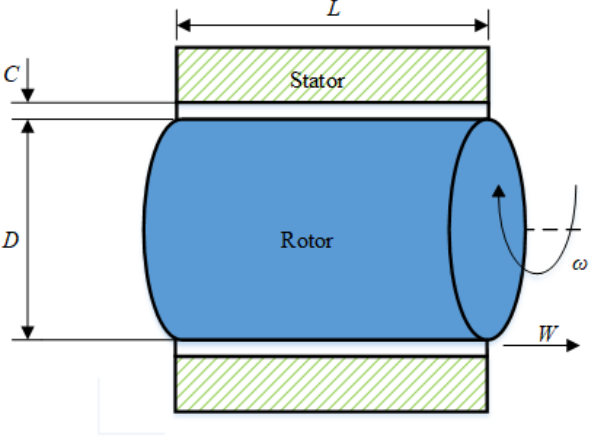
Figure 1. Geometrical parameters of an annular smooth seal.